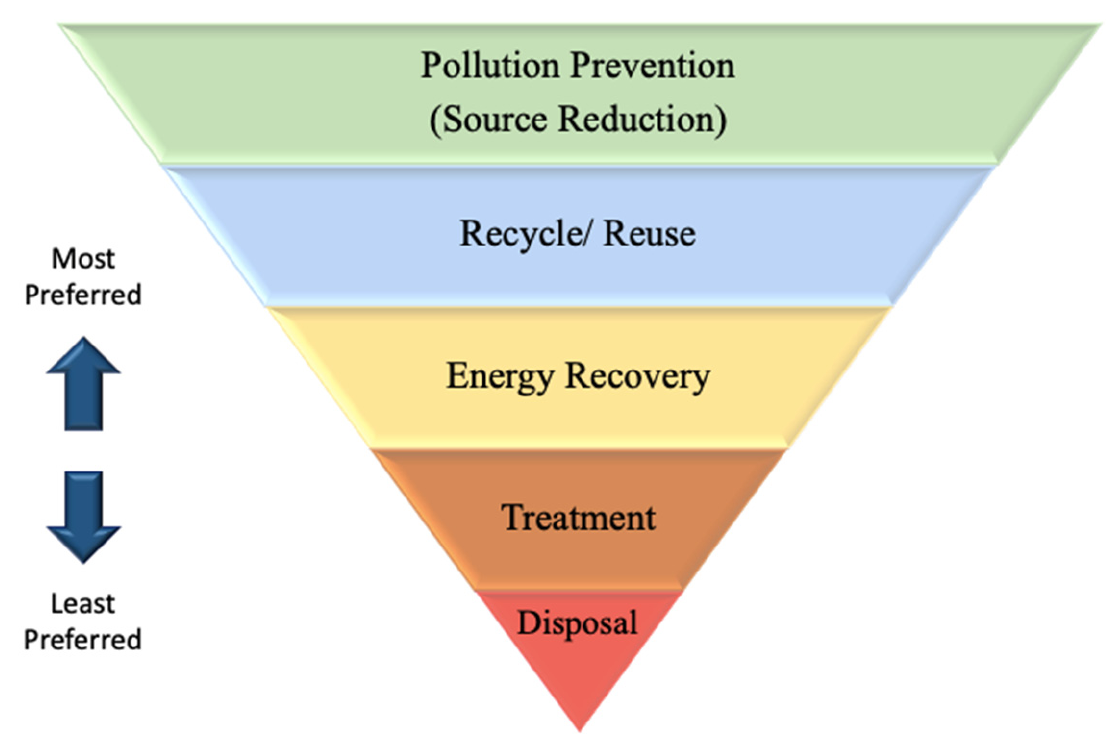
Figure 1. Hierarchy of non-hazardous waste management, Reproduced from [3], the name of theUSEPA: 2017.